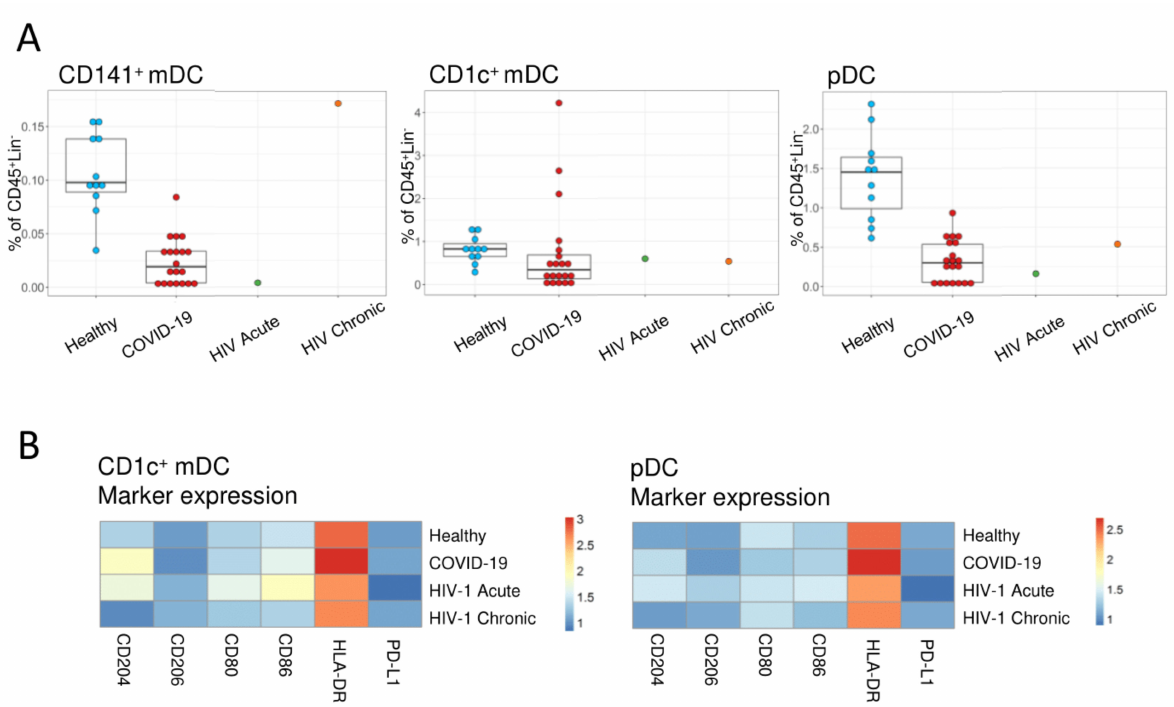
Figure 3. Circulating dendritic cells in acute HIV-1 infection. ( A ) Boxplots showing the frequencies and the medians of the identified population. Each dot represents one subject. ( B ) Heatmap showing the expression of co-stimulatory and activation markers within CD1c+ mDCs and pDCs for the HIV-1 acute and untreated HIV-1 chronic patients, as well as the healthy control and COVID-19 groups. CD141+ mDC marker expression is not shown given the low number of